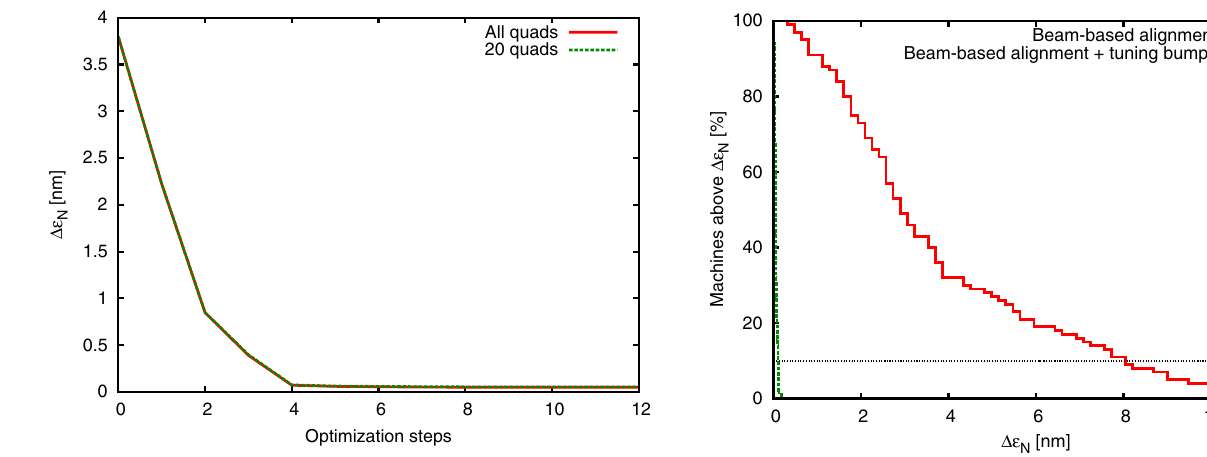
FIG. 25. Integrated histogram showing the number of ma- chines with emittance growth higher than a certain (cid:1) (cid:2) long as no dynamic effects are taken into account, the use of beam-based alignment alone seems to be sufficient to reach the ILC emittance target. However, the additional use of tuning bumps strongly reduce emittance growth such that 90% of all machines have a final emittance growth of less than 0.11 nm.